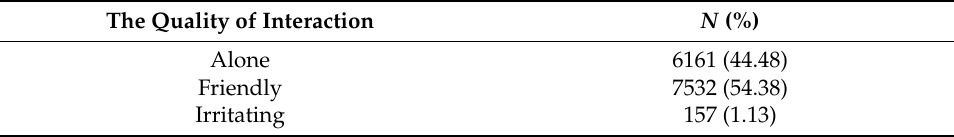
Table 3. The quality of interaction.